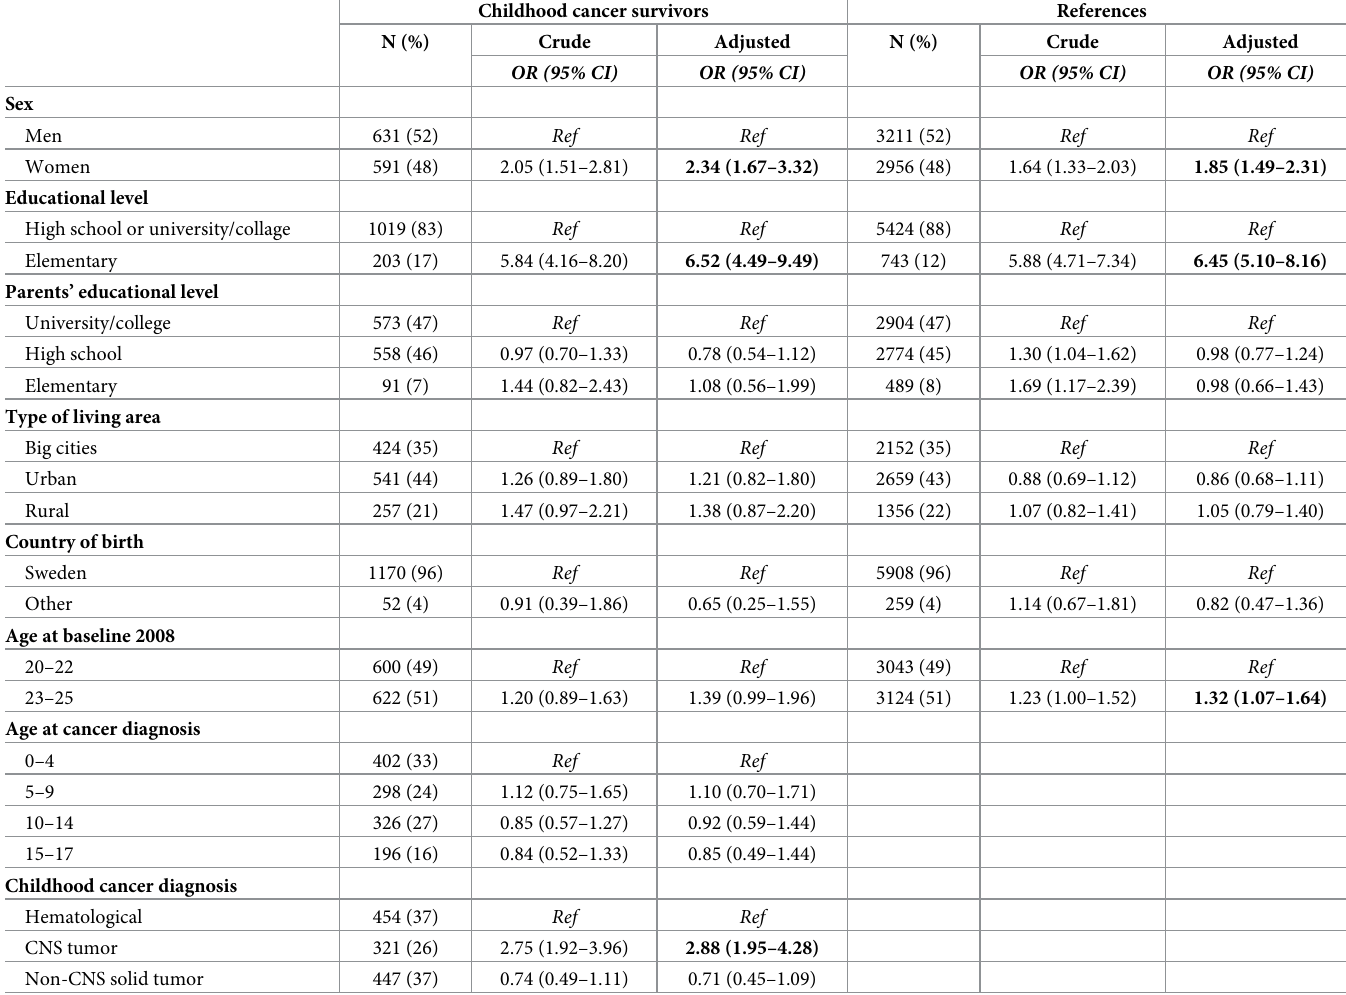
Table 2. Crude and adjusted odds ratio (OR) and 95% confidence intervals (CI) for sickness absence and/or disability pension > 90 days in 2018 among childhood cancer survivors and among references,